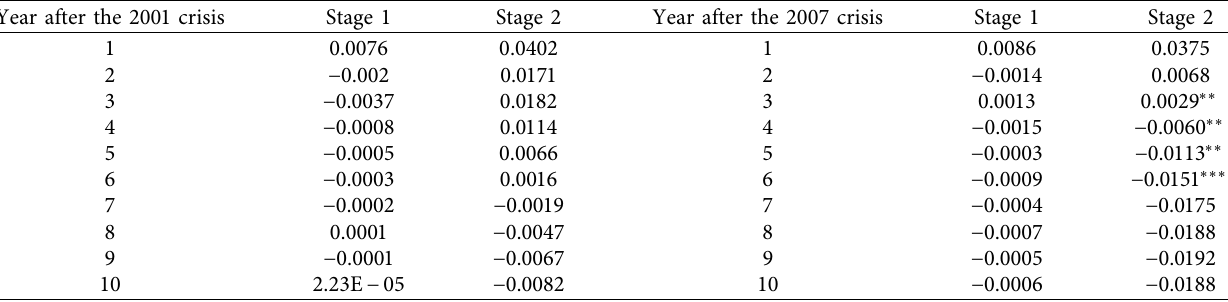
Table 6: Impulse response estimate of the effect of financial crises on efficiency scores.